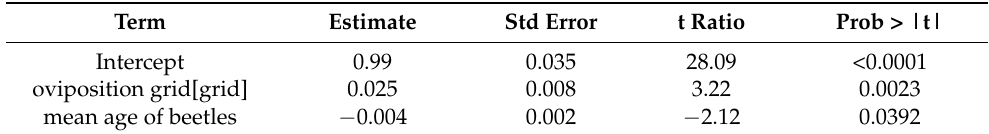
Table 6. Parameter estimates, standard error and significance level (t ratio and p -value) for multiple linear regression model of hatching (%) for experiment 2. Term Estimate Std Error t Ratio Prob > |t| Intercept 0.99 0.035 0.025 − 0.004